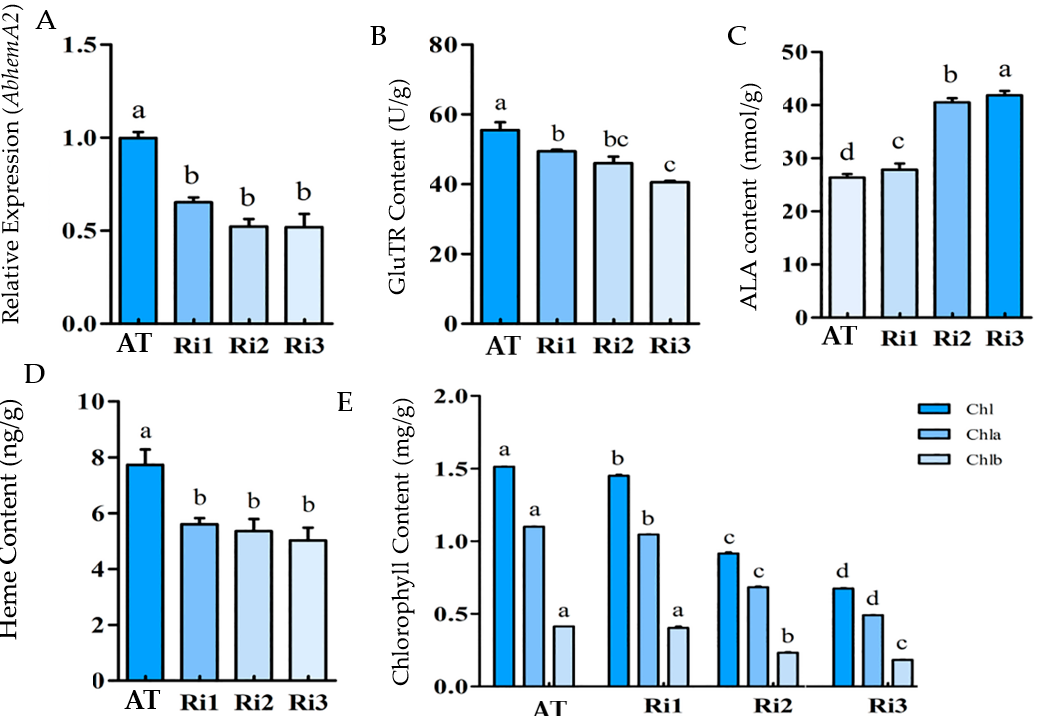
Figure 4. Effects of HemA expression interference on porphyrin metabolism. Relative HemA expression using Tubulin as the reference gene ( A ), GluTR content ( B ), ALA content ( C ), heme content ( D ) and chlorophyll content ( E ). The means denoted by the same letter did not differ significantly at p < 0.05.